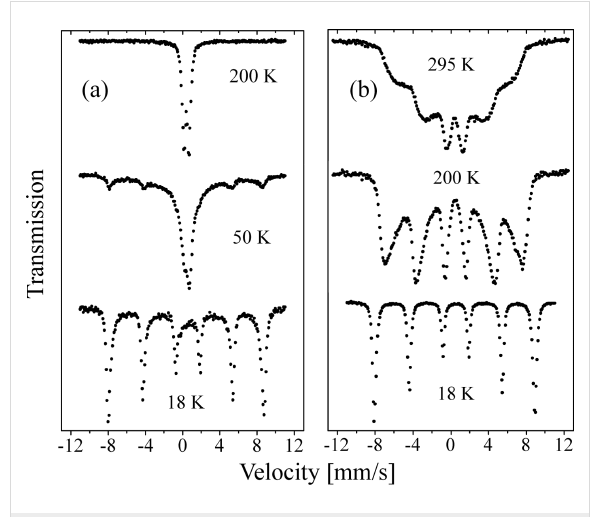
Figure 3: Mössbauer spectra of 8 nm hematite particles (a) coated (non-interacting) and (b) uncoated (strongly interacting) nanoparticles. The spectra were obtained at the indicated temperatures. Reprinted from Frandsen, C.; Mørup, S. Spin rotation in α -Fe 2 O 3 nanoparticles by interparticle interactions, Phys. Rev. Lett . 2005, 94, 027202. Copy- right (2005) by the American Physical